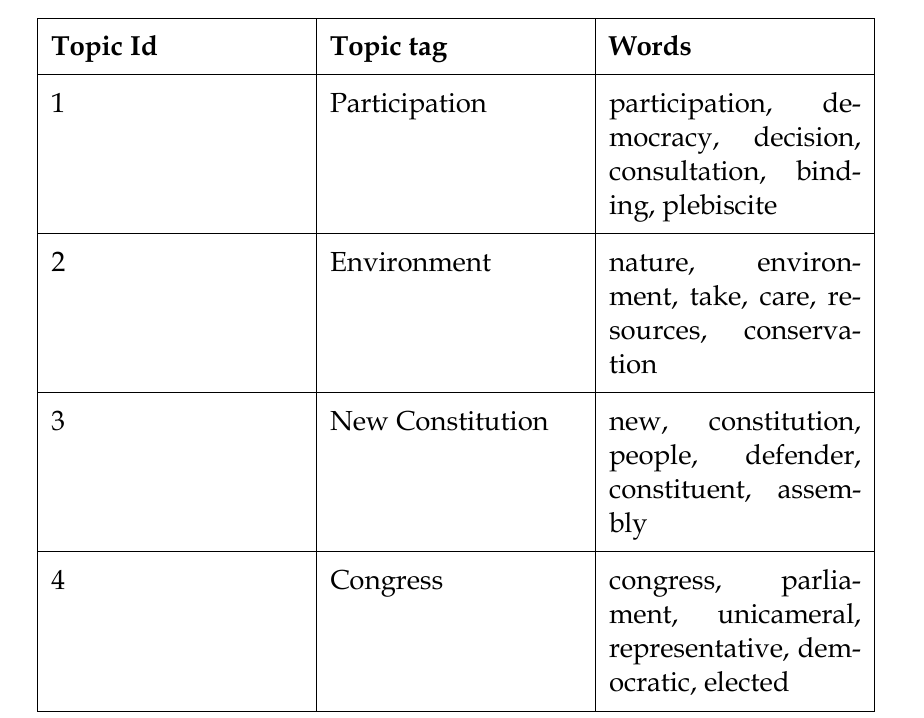
Table B1: Tag and words per topic from topic